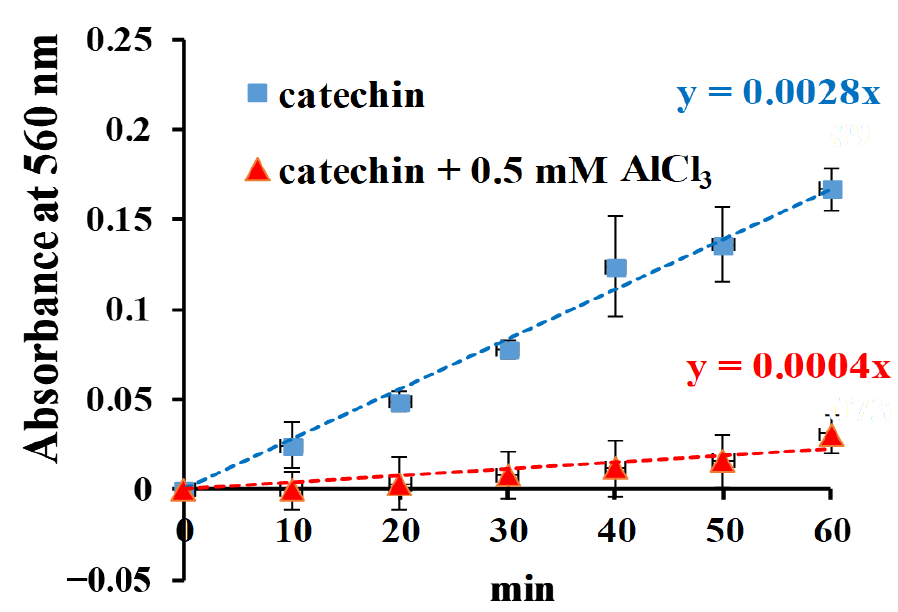
Figure 9. E ff ects of 1 mM catechin or 1 mM catechin upon the addition of 0.5 mM AlCl 3 on Figure 9. Effects of 1 mM catechin or 1 mM catechin upon the addition of 0.5 mM AlCl 3 on nitrotetrazolium blue chloride (NBT) reduction under BLI at 20 W / m 2 for 0–60 nitrotetrazolium blue chloride (NBT) reduction under BLI at 20 W/m 2 for 0–60 min.